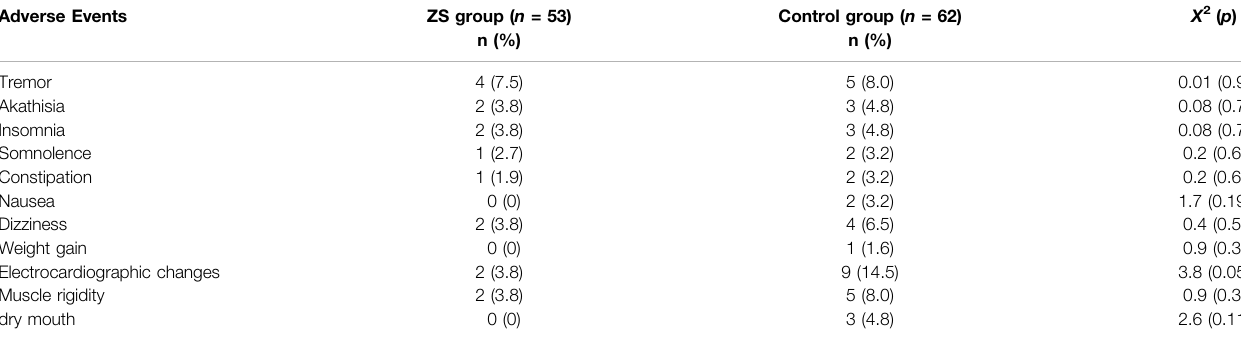
TABLE 4 | Comparison of adverse effects using Treatment Emergent Symptom Scale between ZS group and control group. Adverse